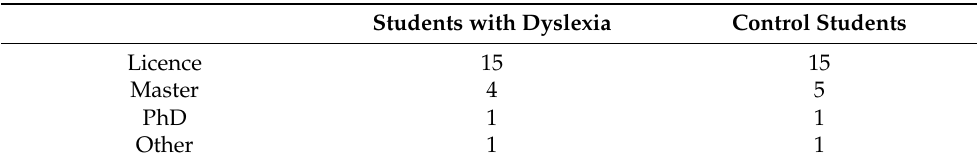
Table 2. Description of participants in the psycholinguistic